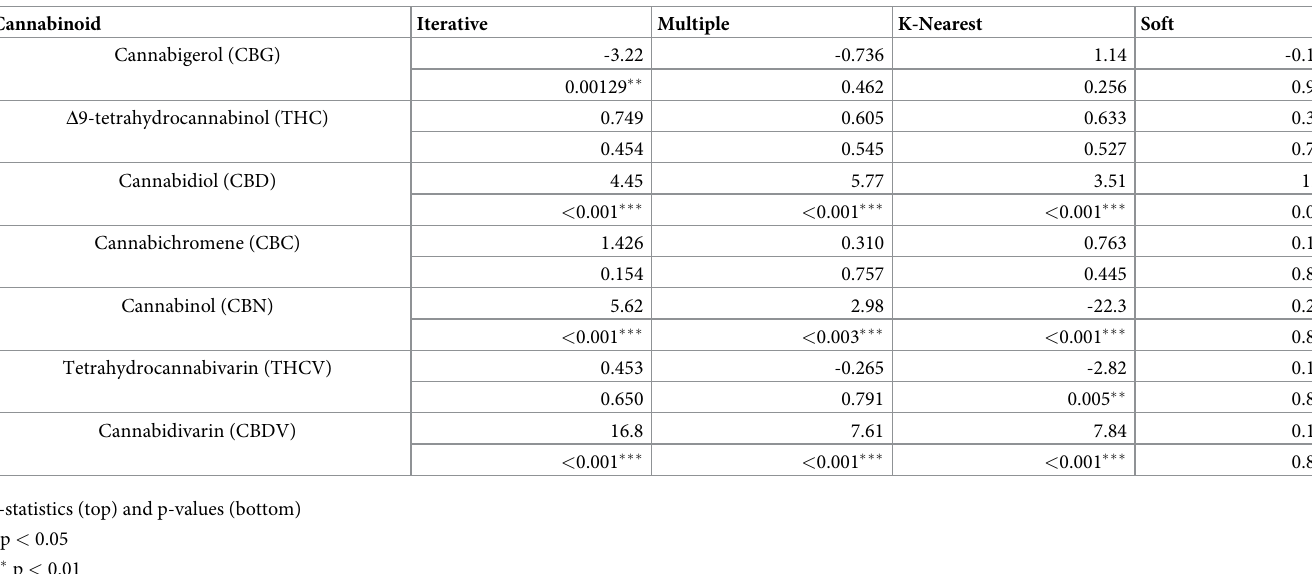
Table 2. Statistics for observed vs. imputed cannabinoid